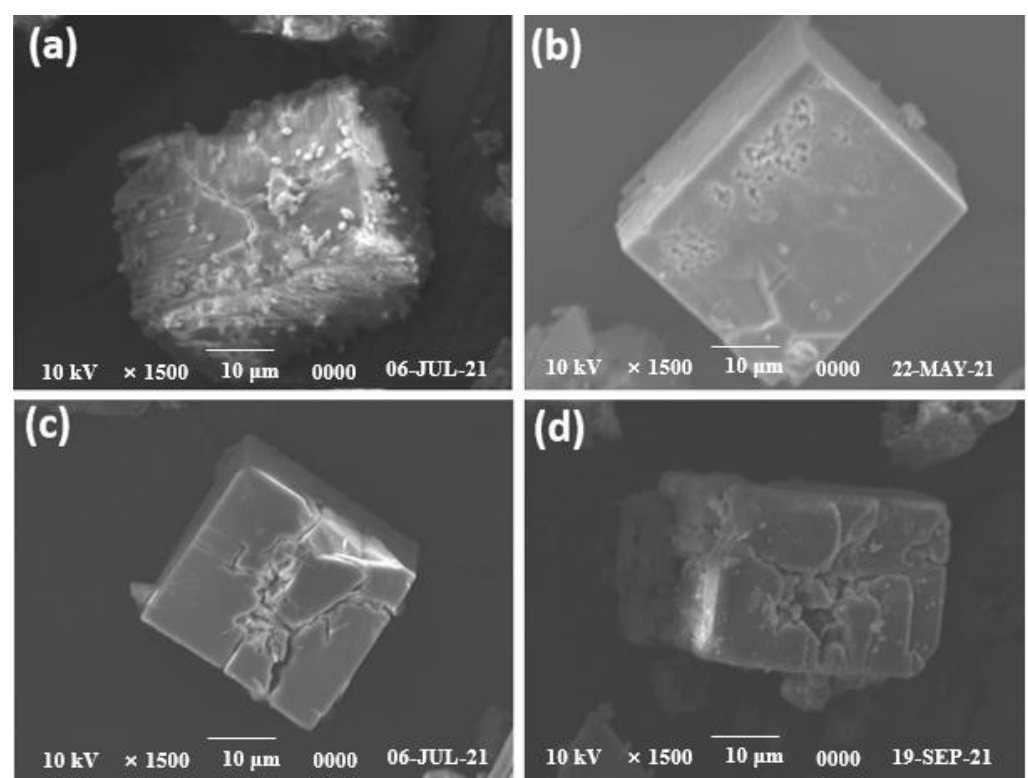
Figure 4. SEM of MOF-5 obtained at different hydrothermal temperatures 120 °C ( a ), 140 °C ( b ), 160 °C ( c ), 180 °C ( d ).